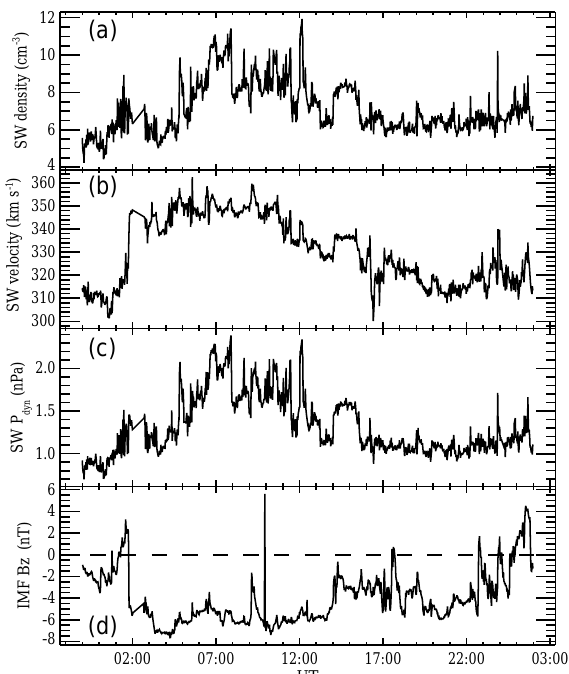
Figure 6. Solar wind properties measured by the Wind satellite on 21 August 2000 in the same format as Fig. 2. The timescale has been shifted by 11min to approximately account for the propagation time between the spacecraft and the